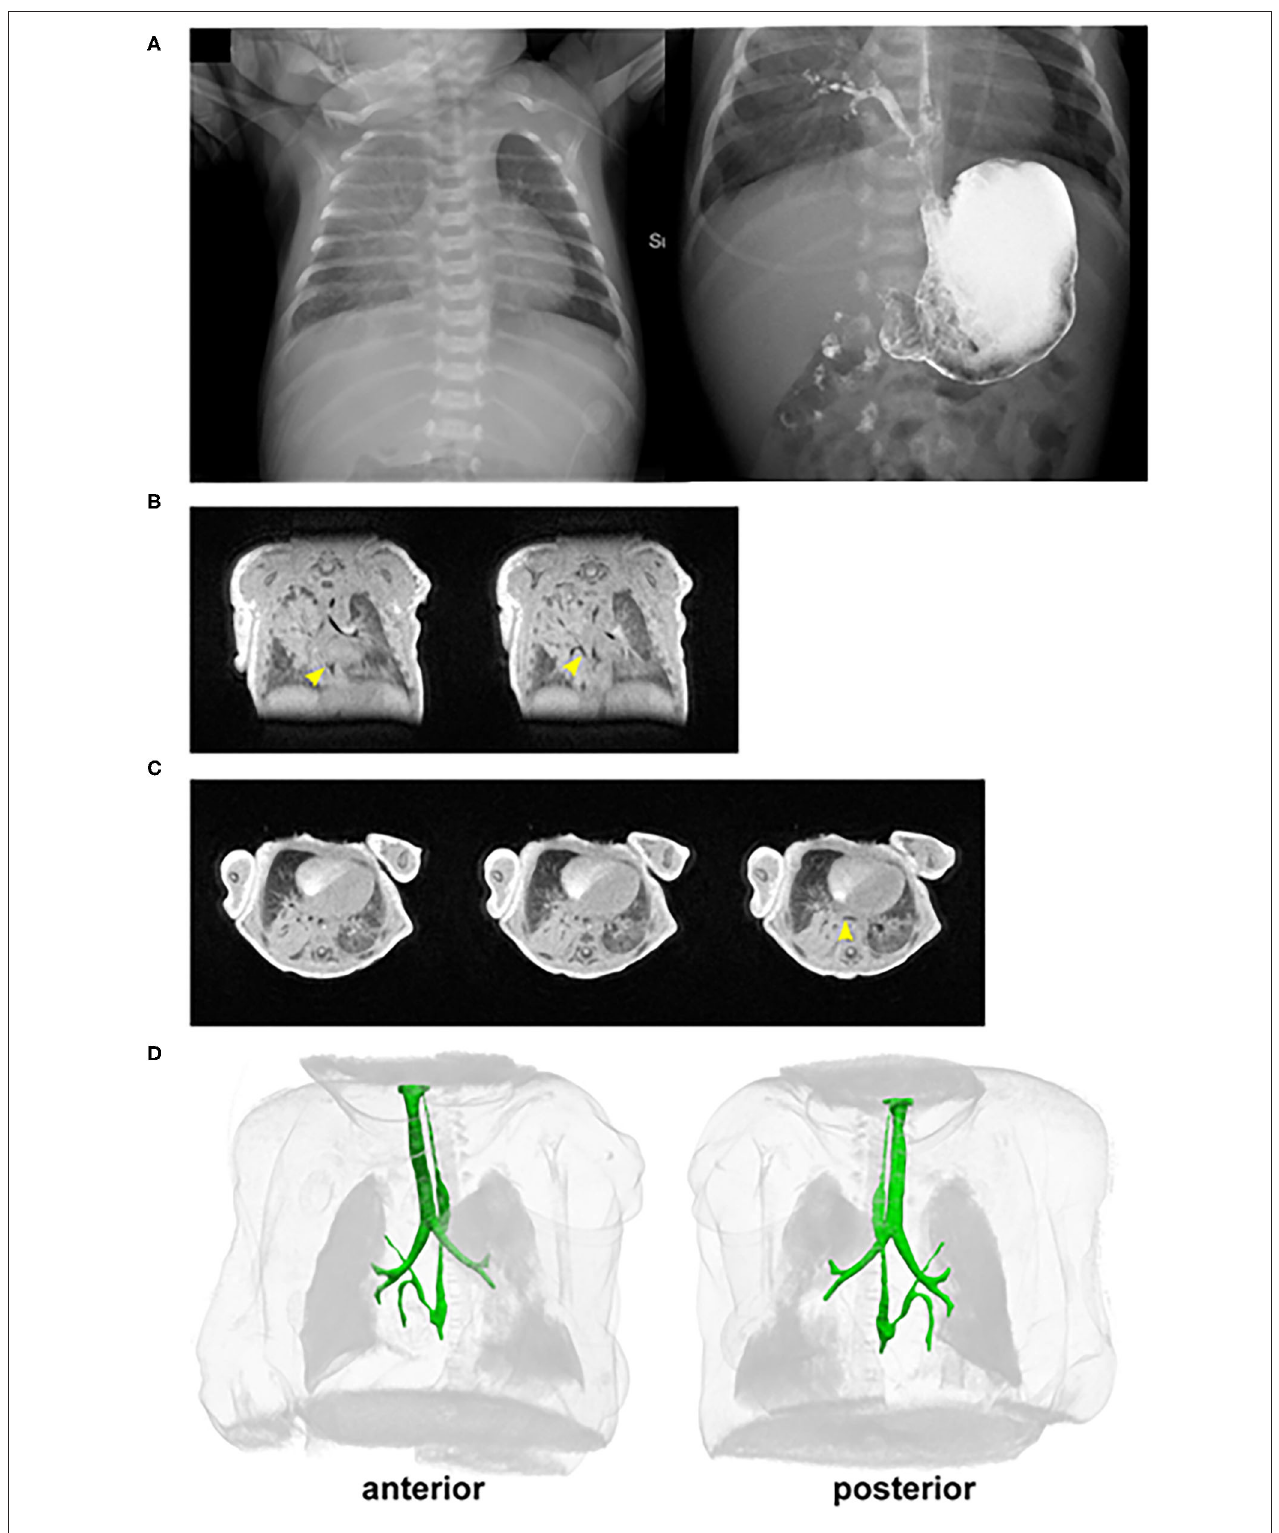
FIGURE 1 | In vivo imaging of the patient with an esophageal bronchus. (A) Pre-repair/resection of (left) chest X-ray and (right) esophageal contrast study reveals opacification of the right upper lobe and the presence of an esophageal bronchus. (B,C) Selected (B) coronal and transverse (C) cross-sections from UTE MRI. Yellow arrowheads point to the fistula connecting from the esophagus to the right upper lobe of the lung. (D) 3D rendering of the chest from UTE MRI. The foregut